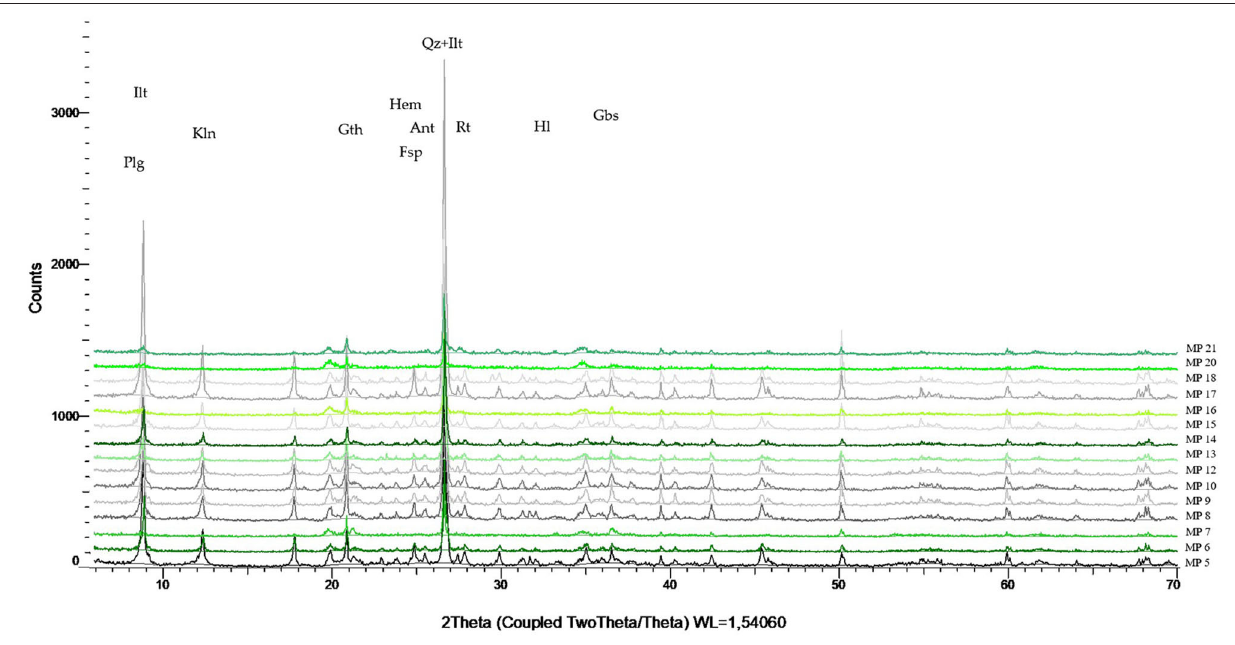
Frontiers in Earth Science |